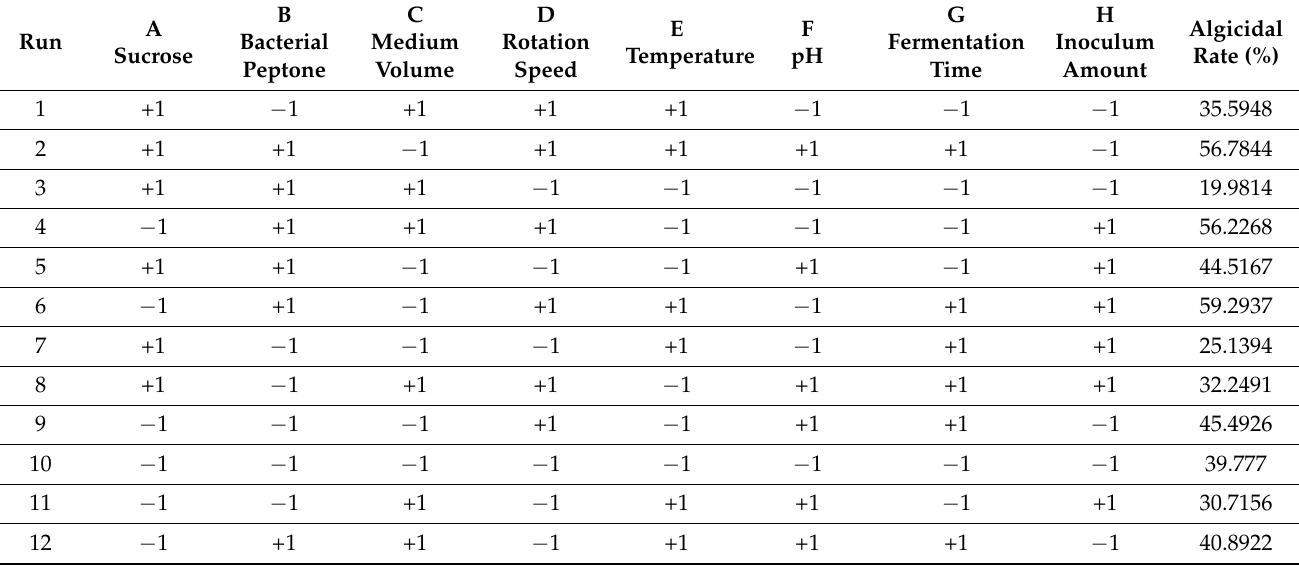
Table 2. Twelve-runs Plackett–Burman design matrix of eight variables and algicidal rate of strain